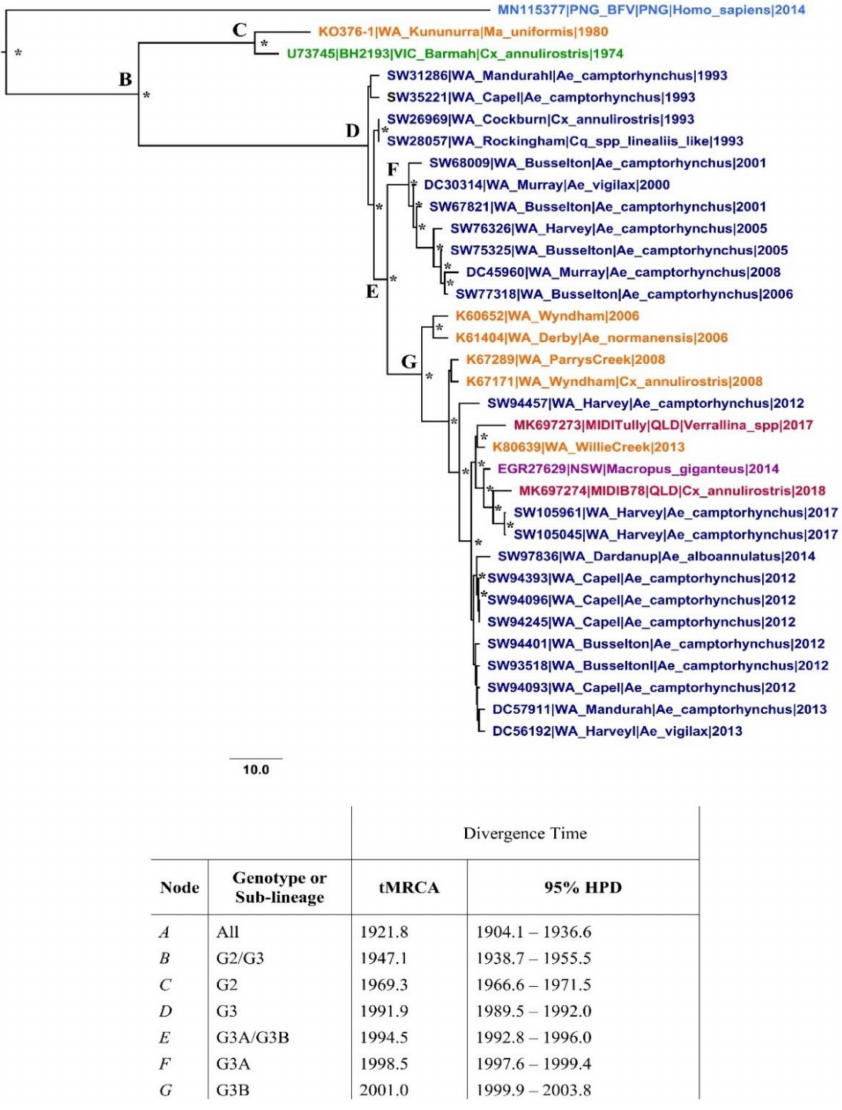
Figure 3. Maximum clade credibility (MCC) tree of the 34-taxon dataset reconstructed assuming a strict molecular clock. Posterior probability values > 0.70 are presented above well-supported nodes (*). Taxa are coloured for their geographical origin, as per Figure 1. The divergence time (time to most recent common ancestor, tMRCA is provided for each major lineage-defining node (A–G). Statistical error is reported as the 95% highest posterior density (95%